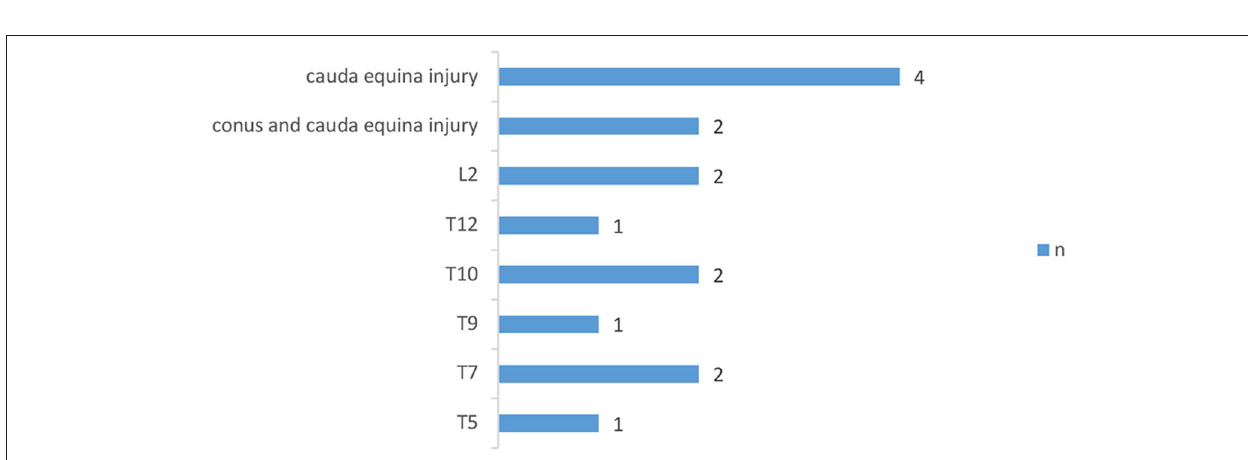
FIGURE 1 | Distribution of neurologic levels of injury in complete SCI patients. T, thoracic levels; L, lumbar levels; (30) n, numbers.